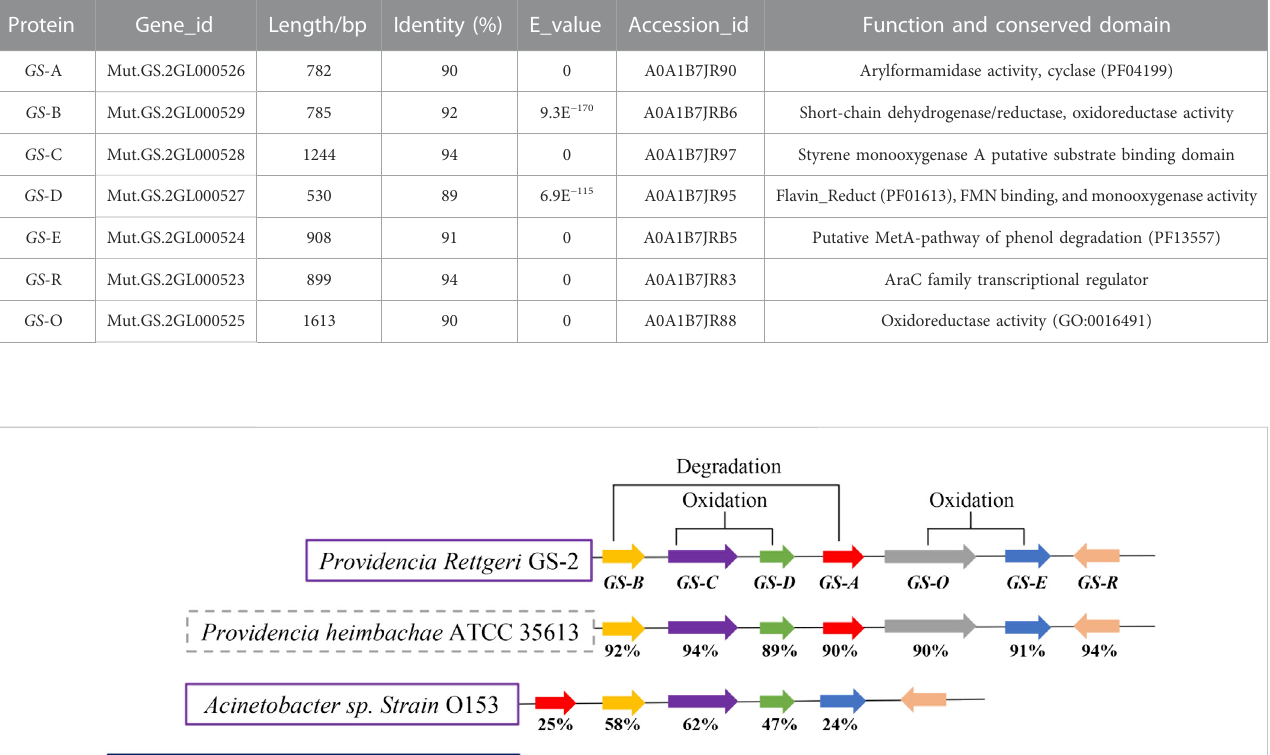
TABLE 3 Predicted conserved domains and putative functions of proteins encoded in Providencia rettgeri GS-2 according the prediction of Providencia heimbachae ATCC 35613.